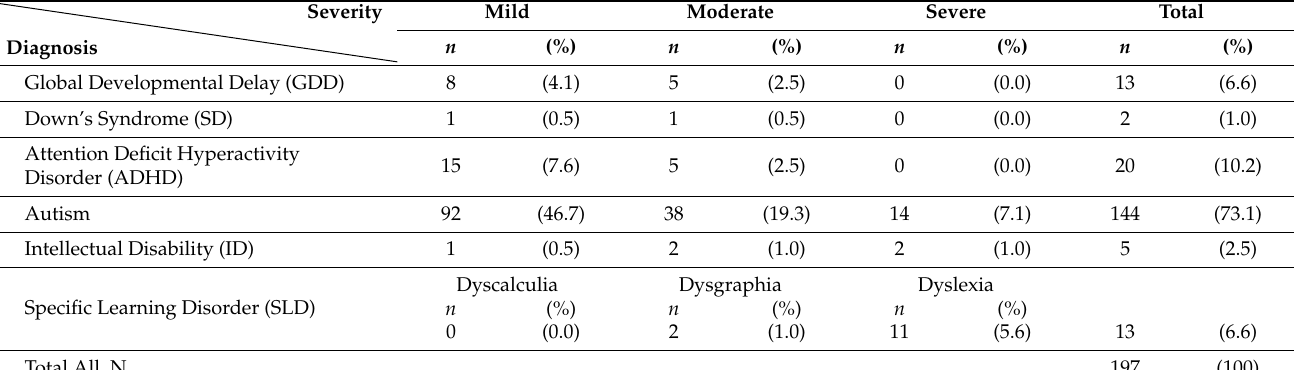
Table 4. Diagnosis characteristics of children with developmental disabilities ( n = 197).